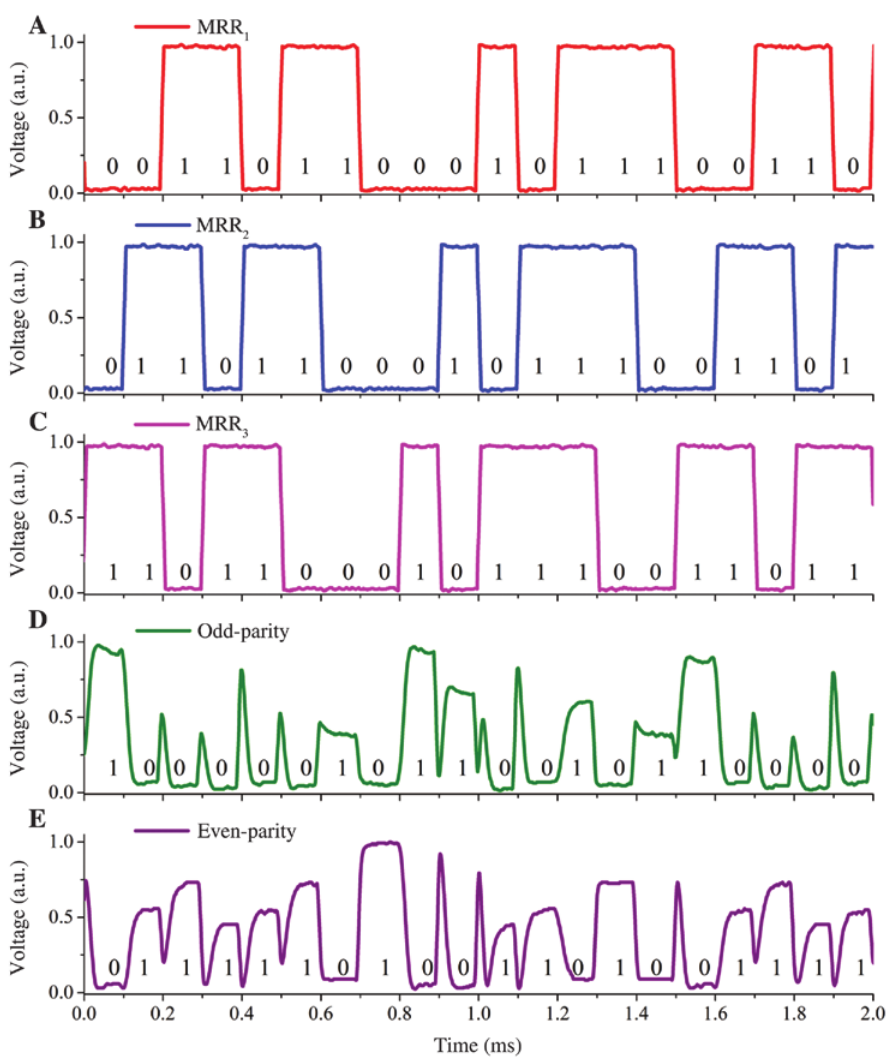
Figure 8: The dynamic performances of the device are